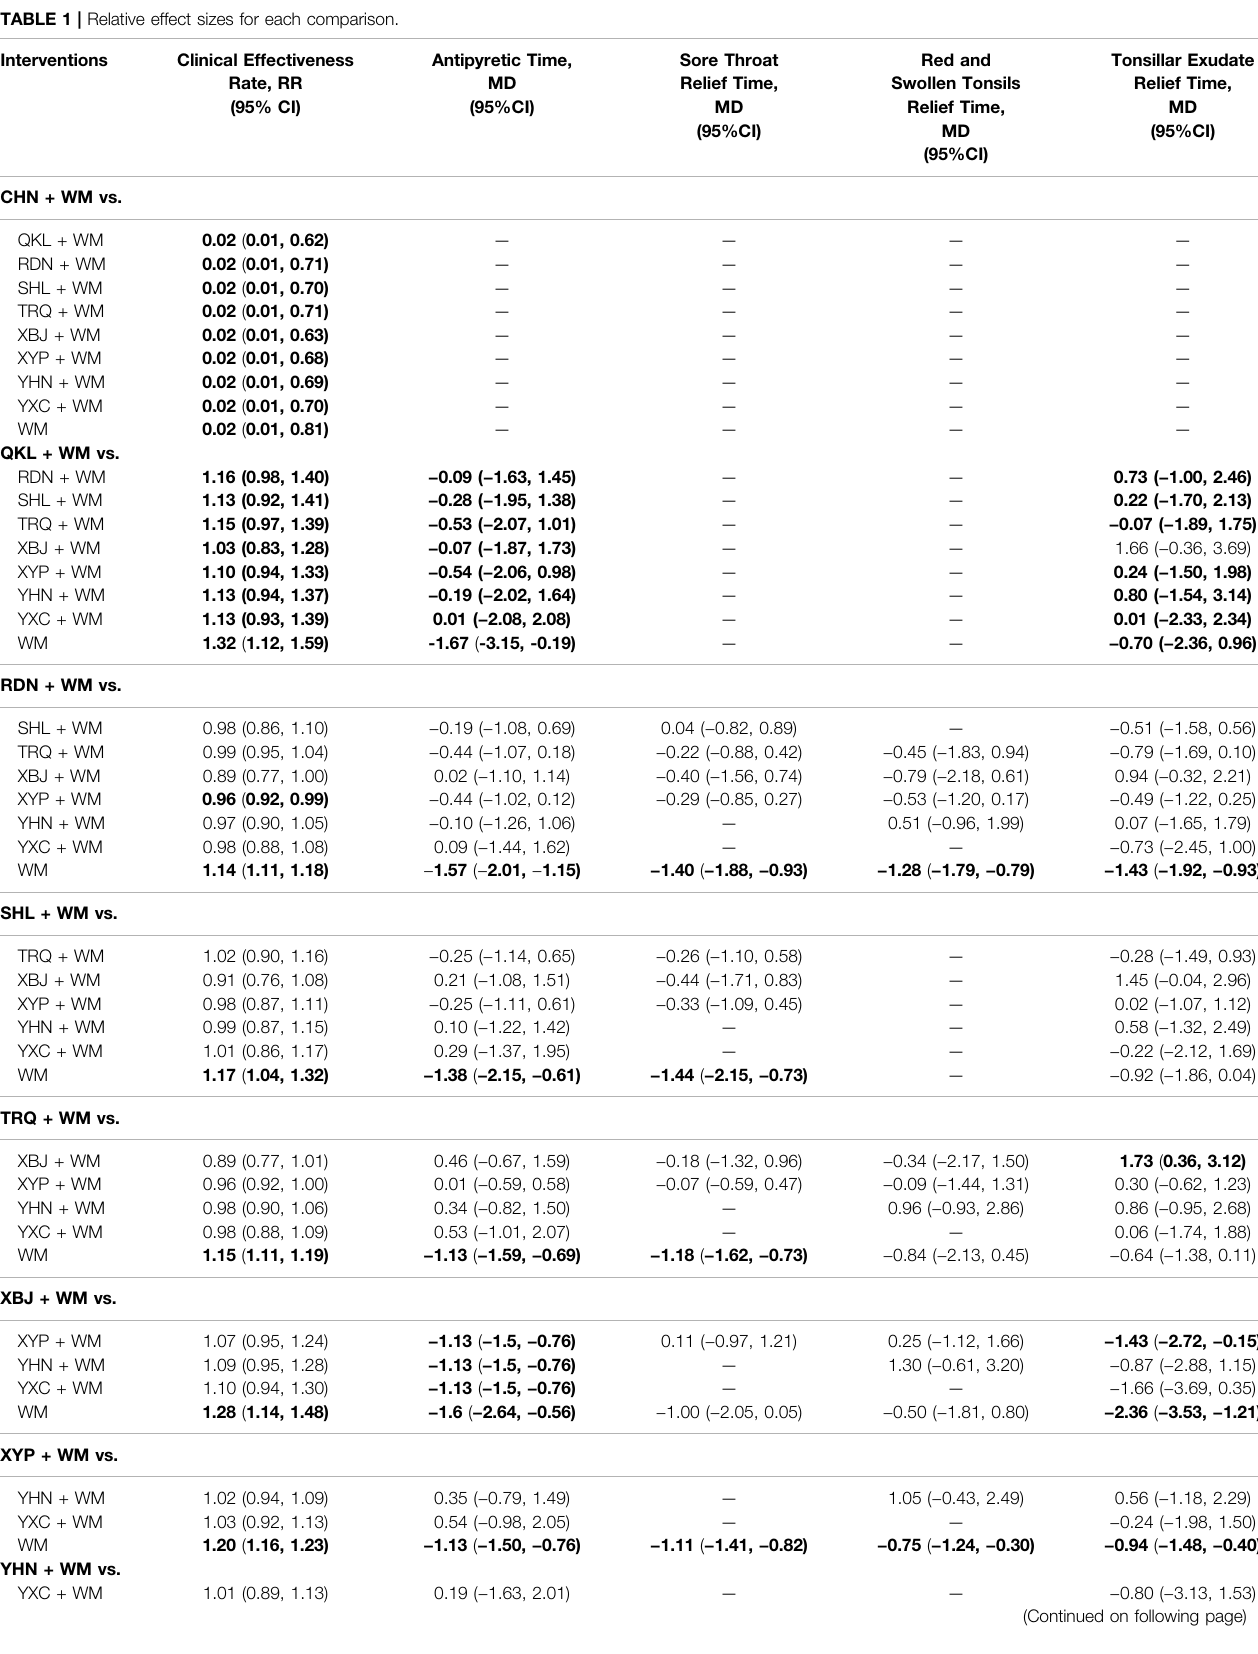
TABLE 1 | Relative effect sizes for each comparison. Interventions